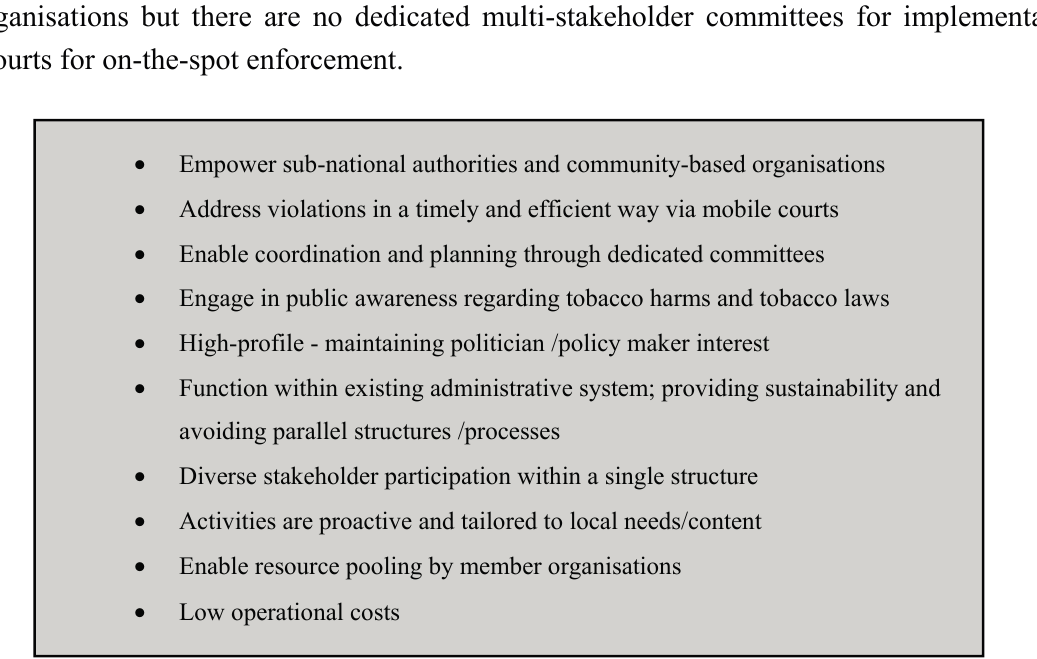
Figure 1. Key features of local Tobacco Control